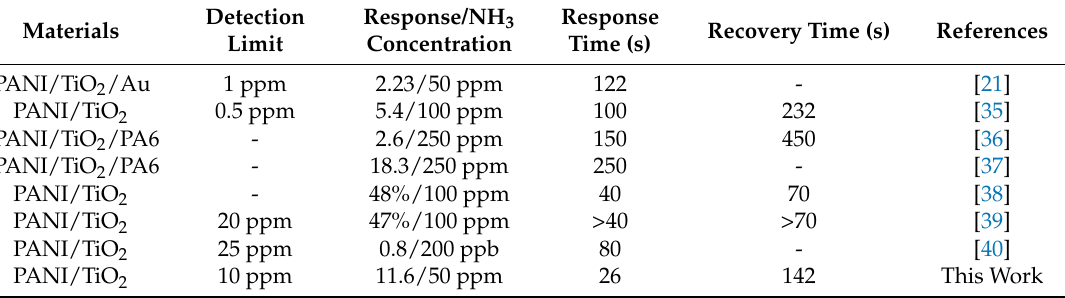
Table 2. Summary of recent publications about the NH 3 detection based the PANI/TiO 2 composites.